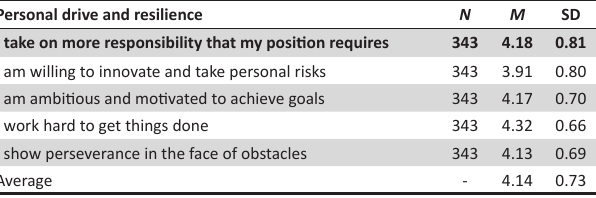
TABLE 3: Respondents’ personal drive and resilience.